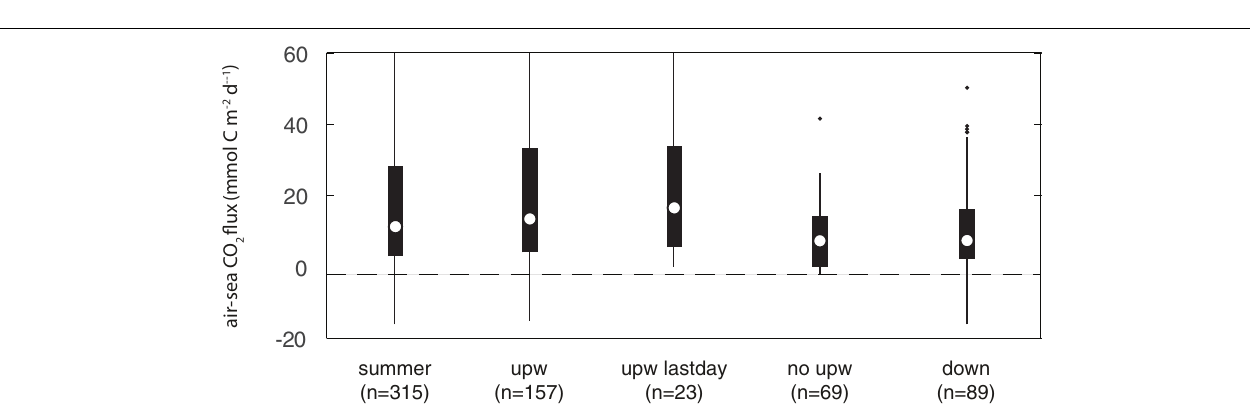
FIGURE 9 | Box plot of the daily mean sensible (red) and latent (blue) heat flux of the full sample (summer), the upwelling days (upw), the last days of the upwelling event (upwlastday), the no-upwelling days (no upw) and downwelling days (down). Circle indicates median, boxes the range 25th and 75th percentiles, lines extend to the most extreme data and dots are outliers.